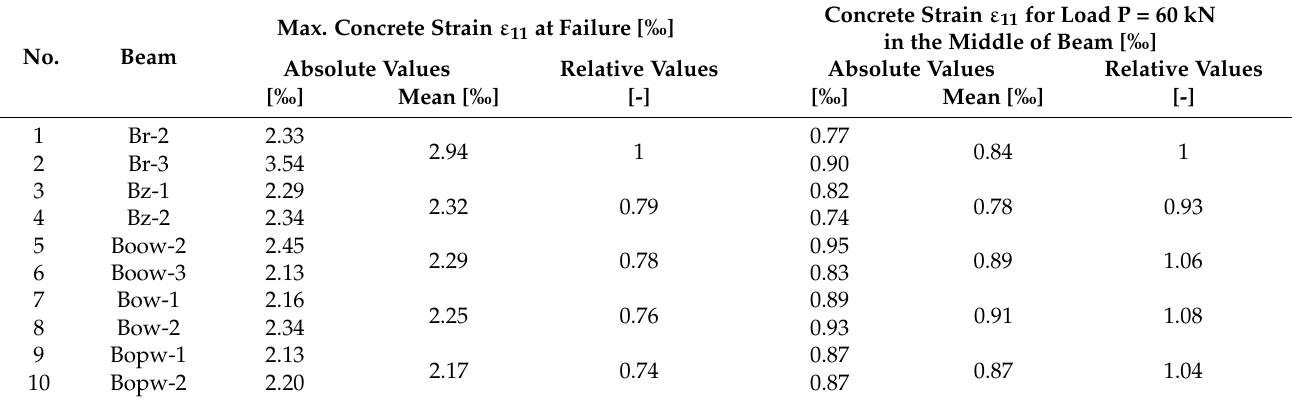
Table 6. Concrete strain values on the top surface of beams in the middle of their span.